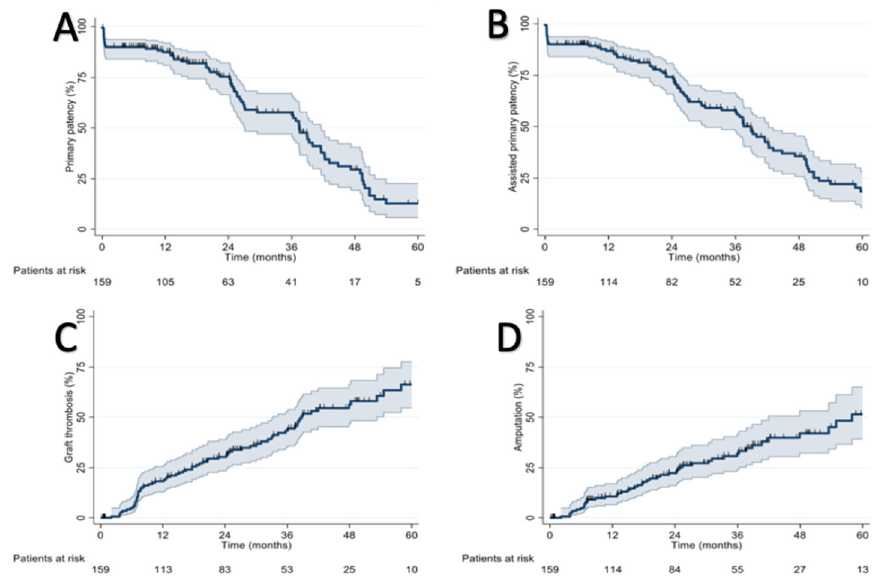
Figure 5. ( A ) Primary patency rates, ( B ) assisted primary patency rates, ( C ) graft thrombosis rates, and ( D ) amputation rates.